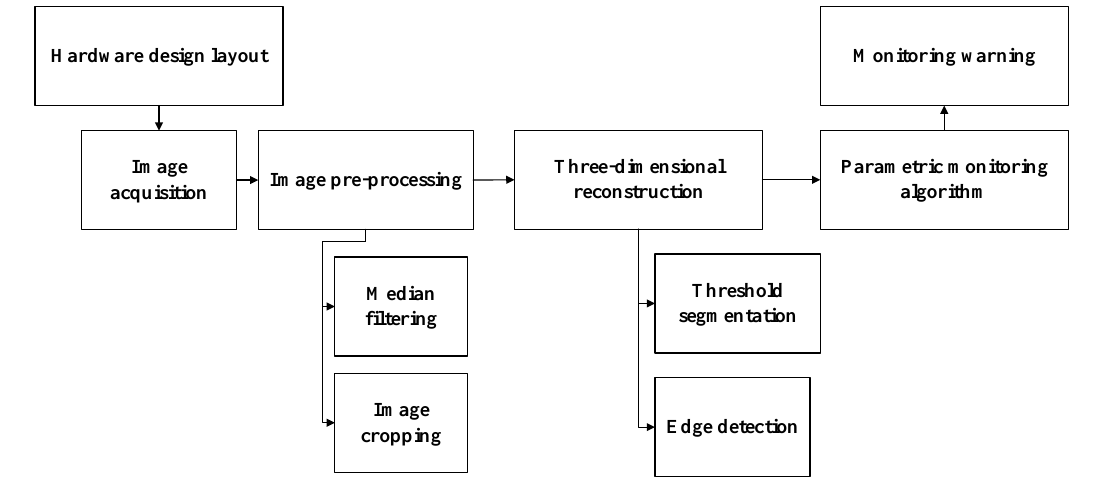
Figure 1. Monitoring system architecture.